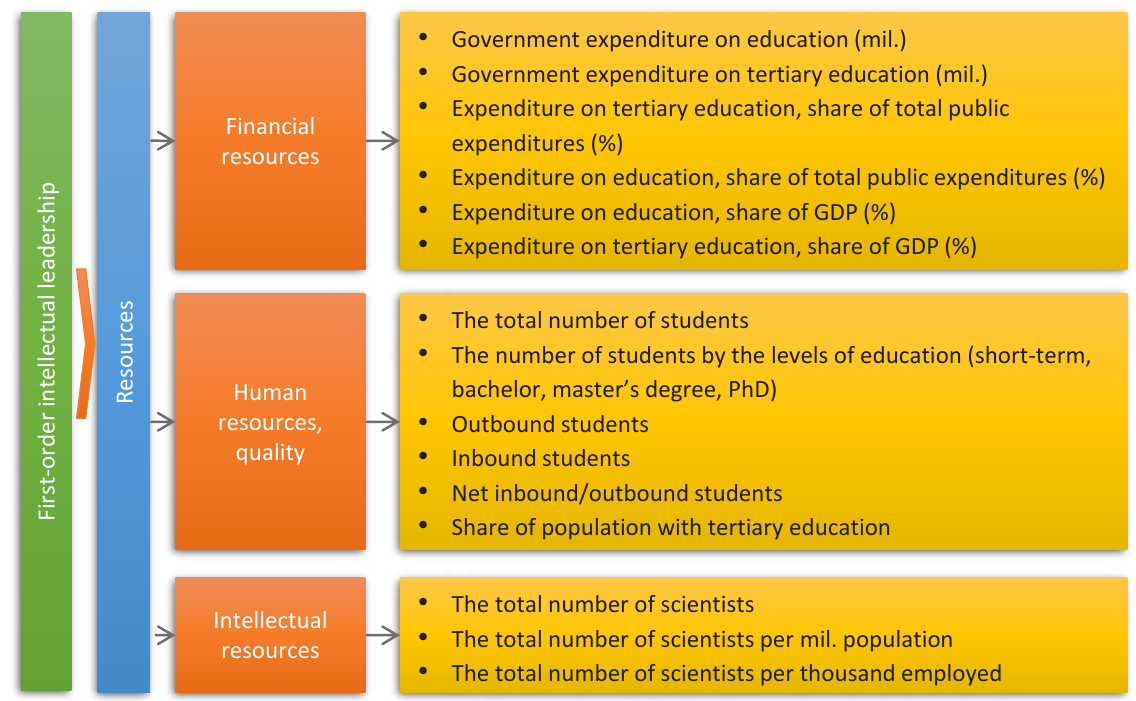
Figure 2. Key indicators of achievement of intellectual leadership first